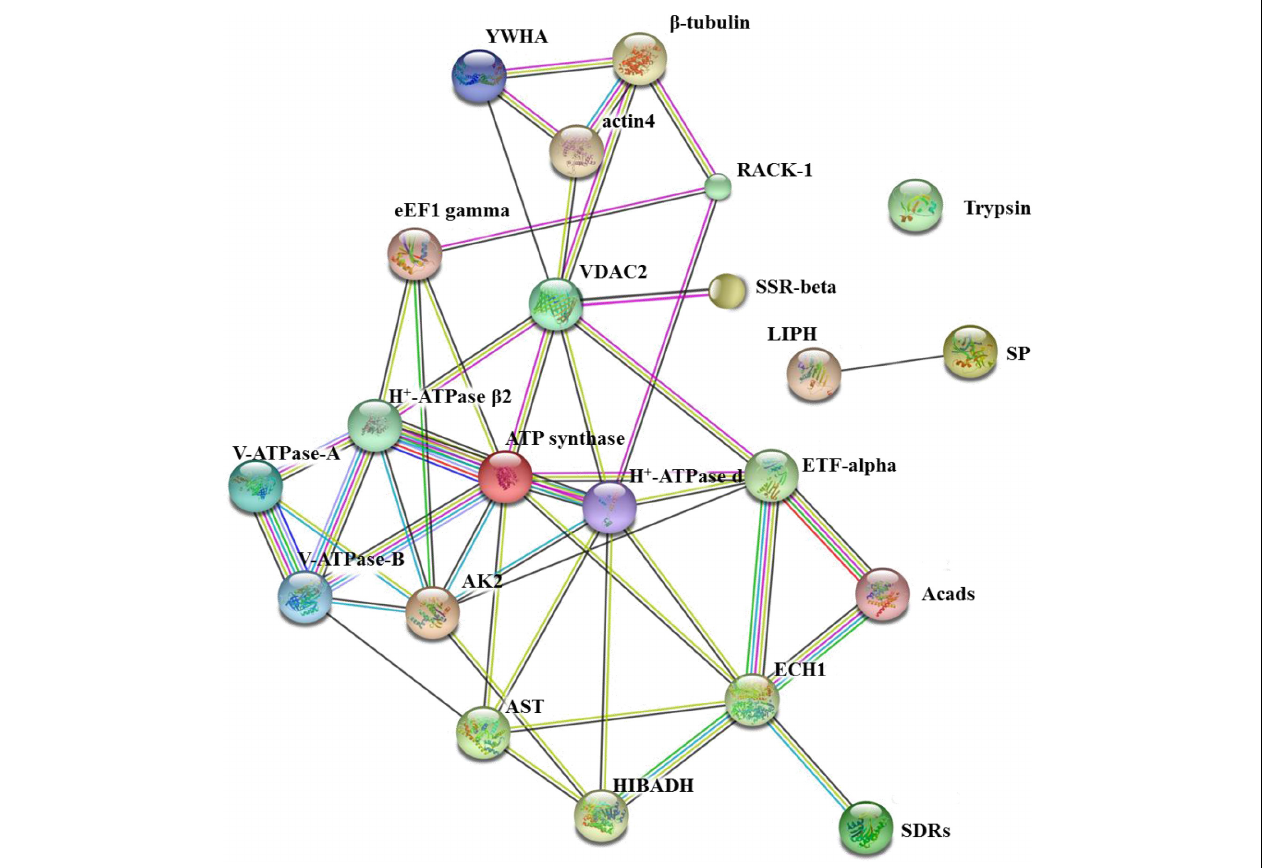
FIGURE 10 | The network of 24 BmNPV-interacting proteins was mapped based on the STRING website information using a database of information on another well-studied insect, D. melanogaster . VDAC2, voltage-dependent anion-selective channel isoform X2; SSR-beta, signal sequence receptor beta subunit precursor; AK2, adenylate kinase 2; actin4, actin-4; eEF1 gamma, elongation factor 1 gamma; AST, aspartate aminotransferase; HIBADH, 3-hydroxyisobutyrate dehydrogenase isoform X1; RACK1, receptor for activated protein kinase C RACK isoform 1; LIPH, lipase member H-A-like; Acads, short-chain specific acyl-CoA dehydrogenase; ECH1, enoyl-coa hydratase precursor 1; H + -ATPase β 2, H + transporting ATP synthase beta subunit isoform 2; V-ATPase-B, vacuolar ATP synthase subunit B; β -tubulin, beta-tubulin; YWHA, tyrosine 3-monooxygenase/tryptophan 5-monooxygenase activation protein epsilon polypeptide; ETF-alpha, electron transfer flavoprotein subunit alpha; SDRs, short-chain dehydrogenase/reductase; V-ATPase-A, vacuolar ATP synthase catalytic subunit A; SP, serine protease precursor; Trypsin, trypsin, alkaline C-like; H+-ATPase d, H+transporting ATP synthase